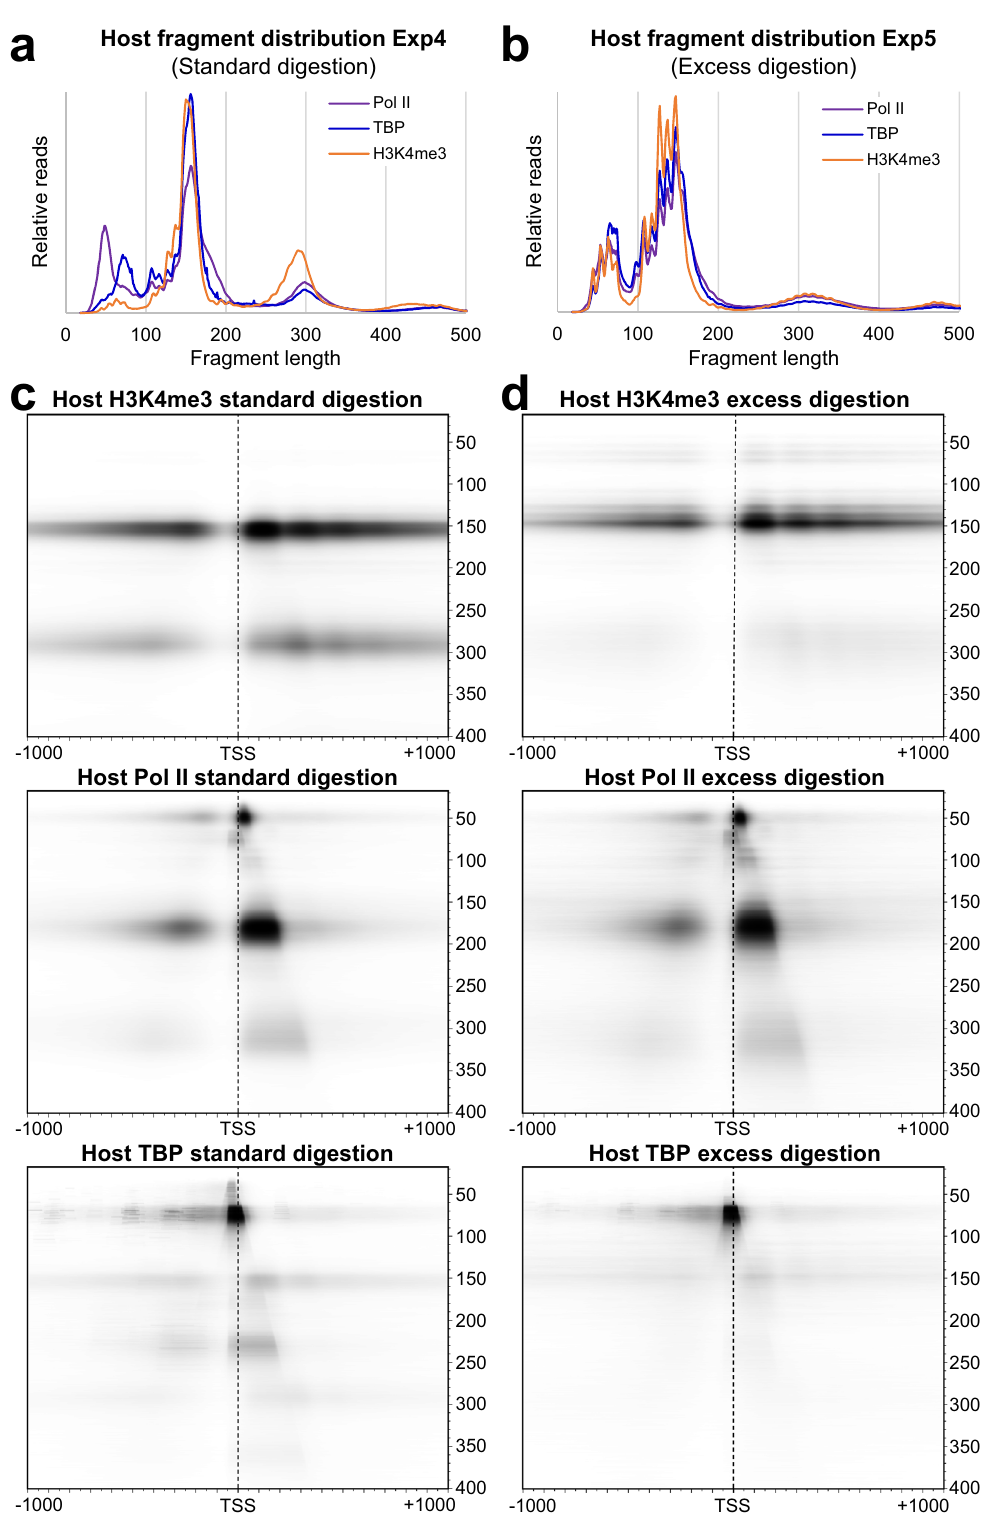
Fig. 7 FragMaps resulting from different extents of DFF digestion. a , b Total fragment distributions from Pol II, TBP, and H3K4me3 datasets from the standard digestion condition (Exp4) and the excess digestion condition (Exp5). c , d fragMaps of Pol II, H3K4me3, and TBP showing 18 – 400bp fragments positioned ±1000 bp around the MaxTSS of 12,229 truQuant promoters with either ( c ) standard (Exp4) or ( d ) excess digestion (Exp5). Exp5 datasets are each a combination of two replicas ( n =